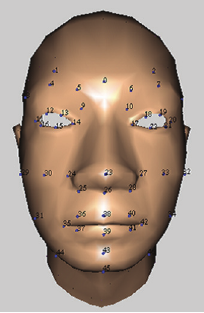
Figure 2: The control points are a subset of MPEG-4 feature points (FPs) and some additional points. The total number is forty-seven for the test models. We put more control points around eyes and mouth since those facial parts need to be deformed more flexibly than other facial parts to make facial